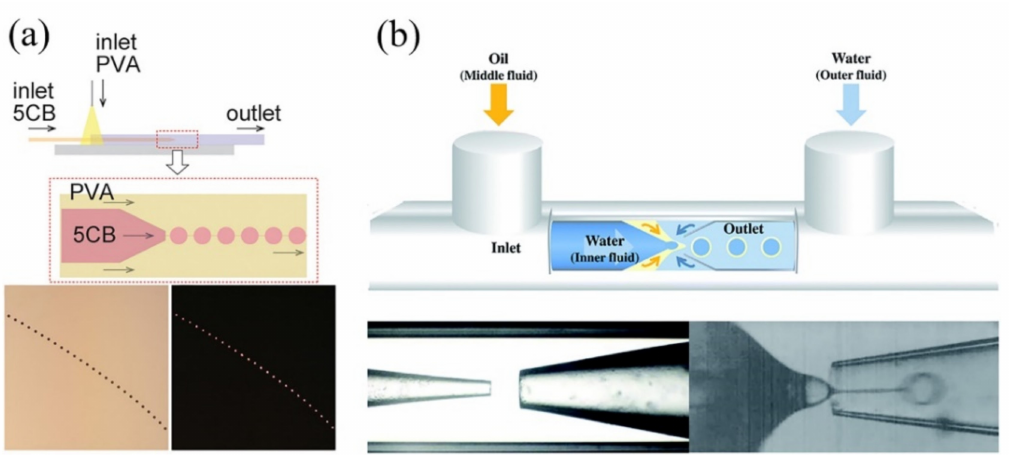
Figure 5. ( a ) LC necklace structure prepared by co-flow microstructure. Reprinted with permission from ref. [93]. Copyright 2020 American Chemical Society. ( b ) LC double emulsion droplets produced by the combination of co-flow and flow- focusing geometries. Reprinted with permission from ref. [89]. Copyright 2016 Royal Society of